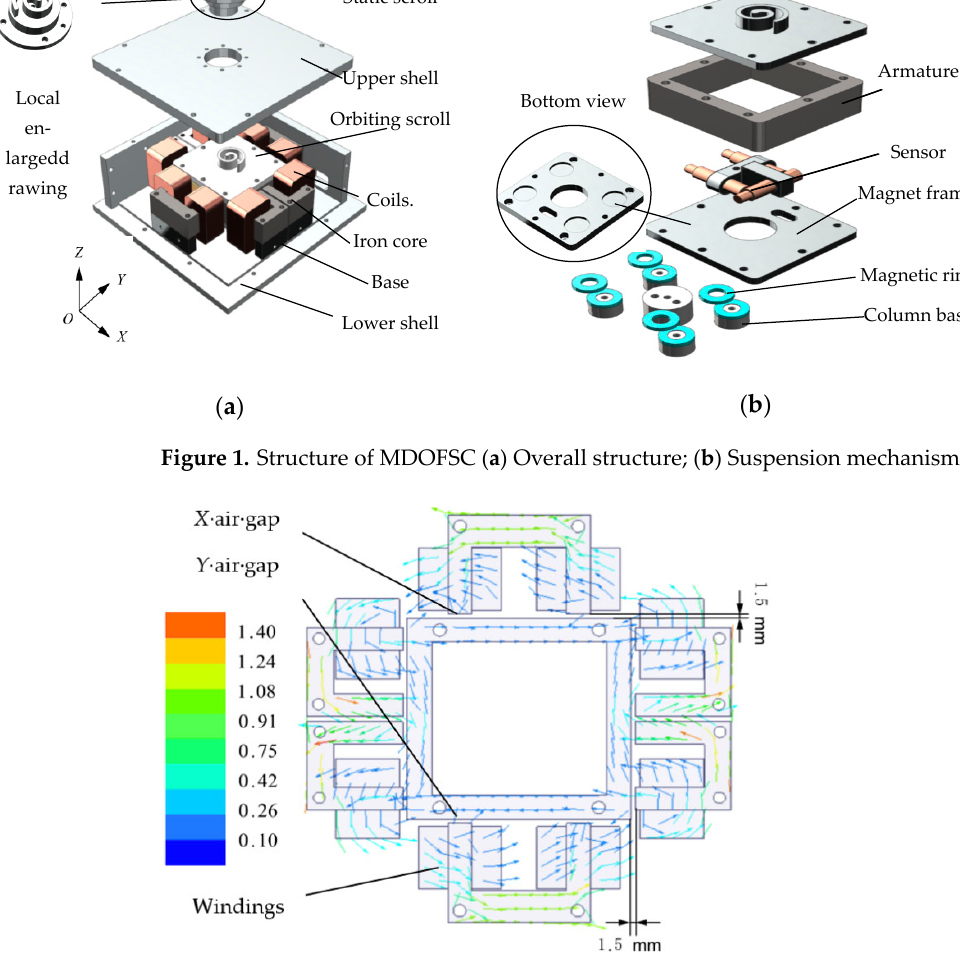
Figure 2. Structure of MDOFSC Magnetic flux density distribution on the electromagnet. Current = 2 A, Air gap x , y = 1.5 mm, and N x = 235, N y = 260.